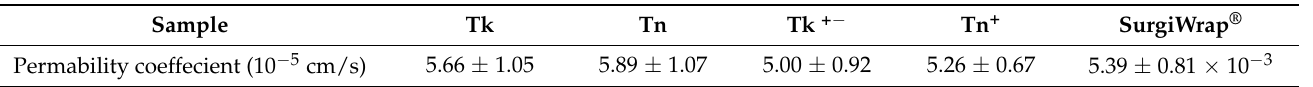
Table 2. The permeability coefficient of BSA through different CSNFMs and SurgiWrap ® . Sample